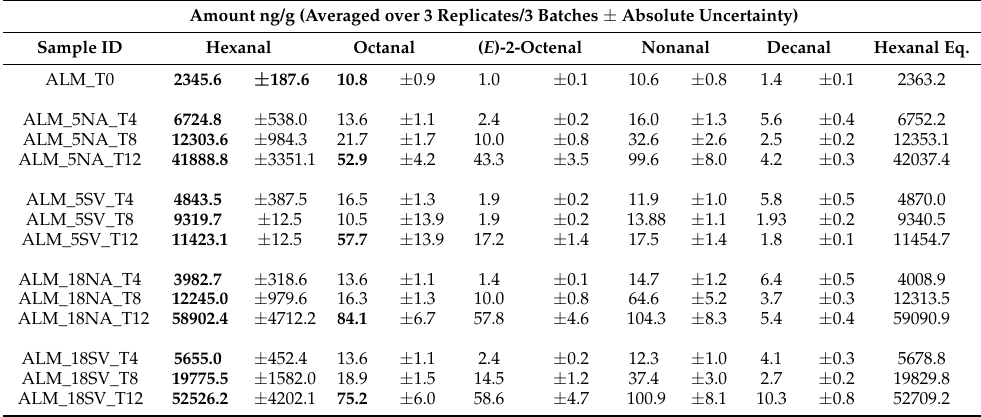
Table 5. Amounts expressed as ng/g for quantified targeted aldehydes in almond samples. In bold are the analytes whose concentration exceeds the OTs (OAV >